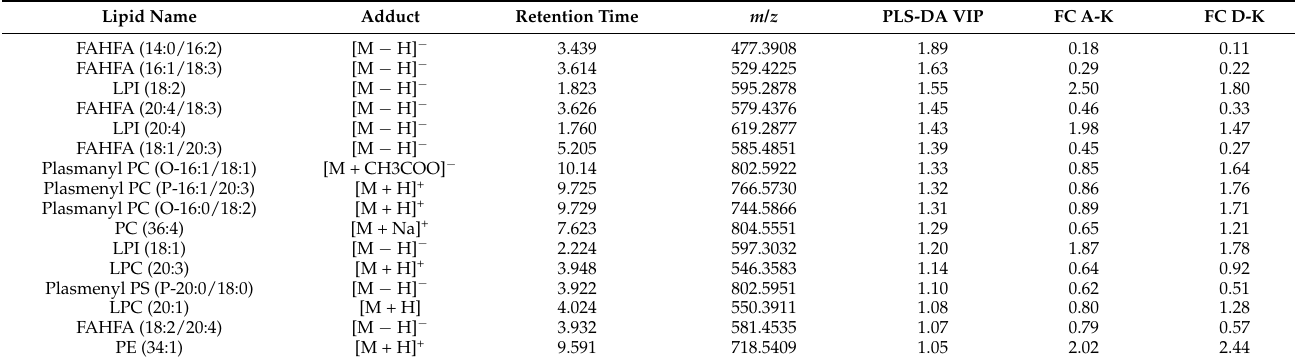
Table 4. List of VIP polar lipids from the PLS-DA model based on male samples only.